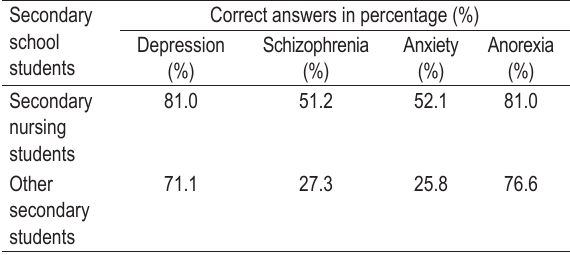
TABLE 2. The comparison of correct answers in the mental health